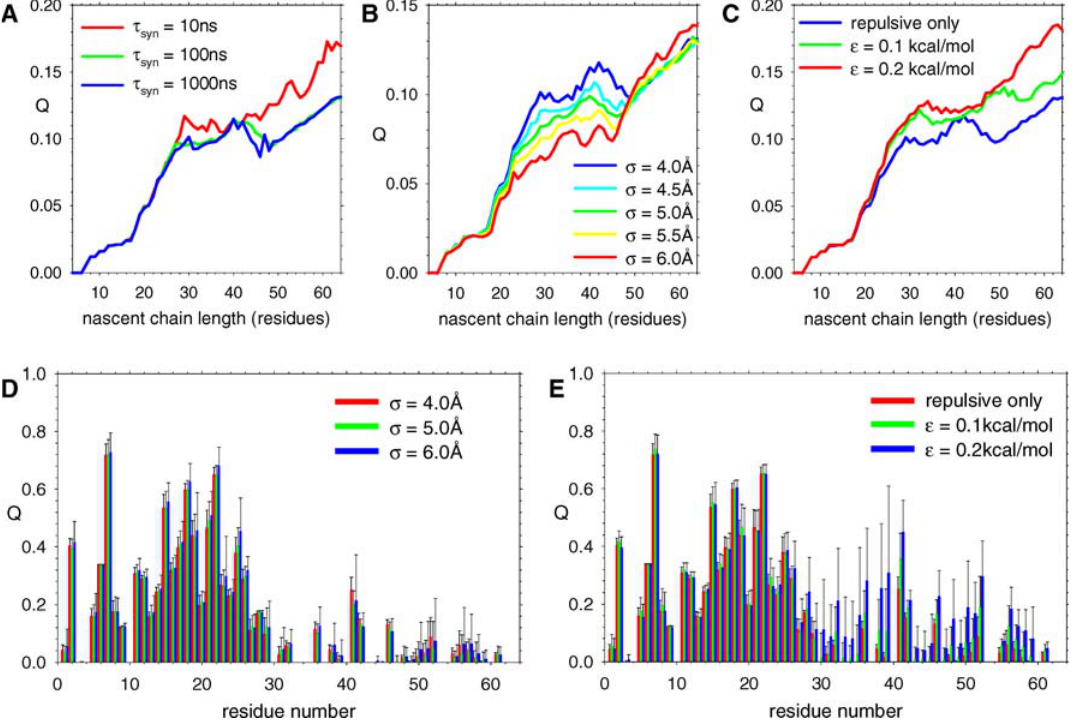
Figure 11. Parameter Sensitivity of Coupled Synthesis–Folding Simulations of CI2 (A) Mean values of Q during coupled synthesis–folding of CI2 comparing the effects of using different timescales for amino acid synthesis ( s syn ). (B) Same as (A), but comparing the effects of assigning larger radii to ribosome pseudo-atoms. (C) Same as (A), but comparing the effects of including energetically favorable interactions between the nascent protein and the ribosome. (D) Distribution of mean Q res values obtained during the synthesis of the final amino acid, comparing the effects of assigning larger radii to ribosome pseudo-atoms; error bars indicate the standard deviation of values obtained from 30 independent trajectories. (E) Same as (D), but comparing the effects of including energetically favorable interactions between the nascent protein and the ribosome. DOI: